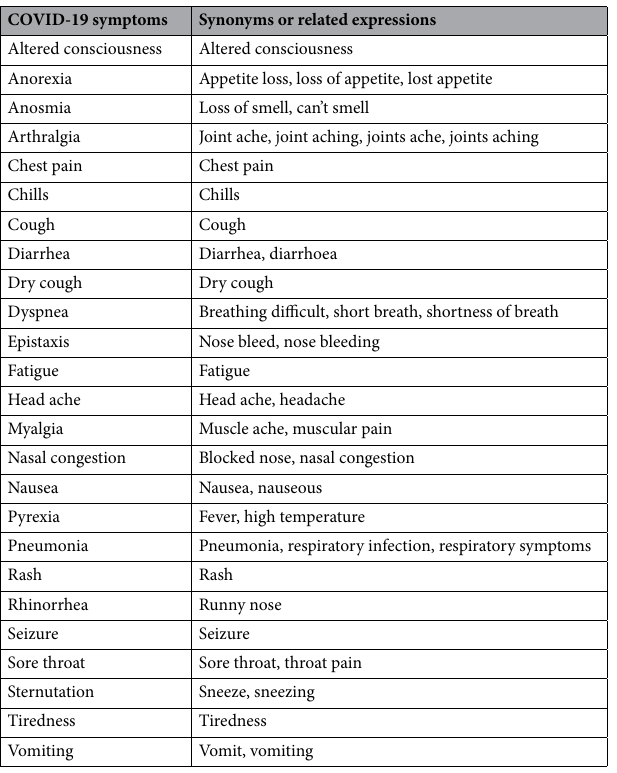
Table 2. 25 symptoms related to COVID-19 (as identified by UKHSA 10 ) and their synonyms or related